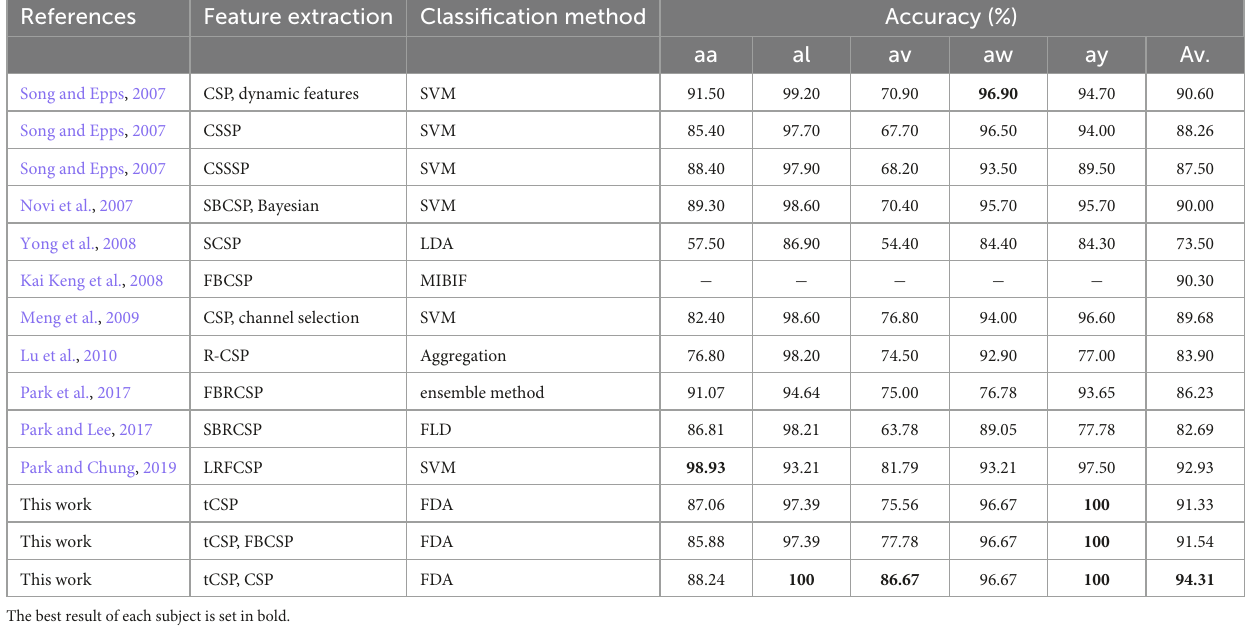
TABLE 3 Comparison of the classification performance for dataset IVa in BCI competition III.